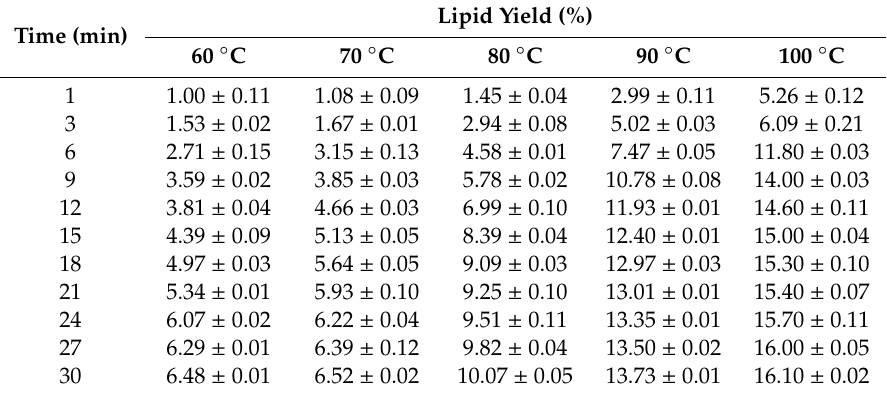
Table 1. The yield of microalgal lipids by MAE of Nannochloropsis sp. using MAE-brine at di ff erent extraction temperatures.